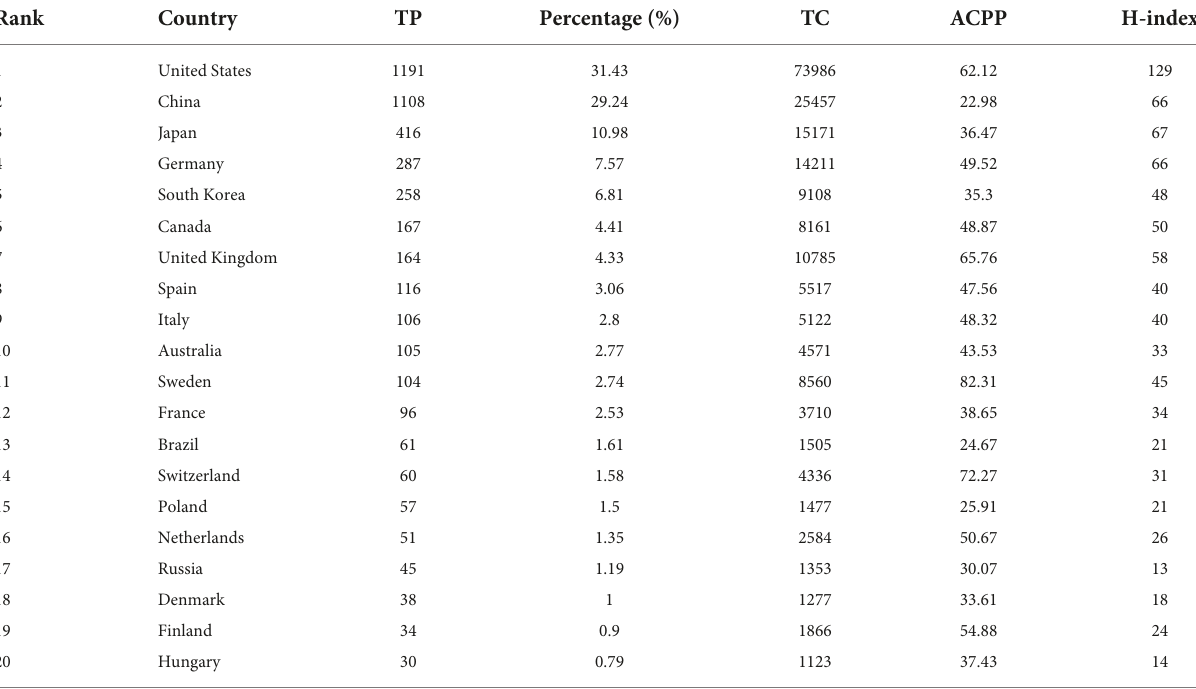
TABLE 1 Top 20 most productive countries in the field of stroke and